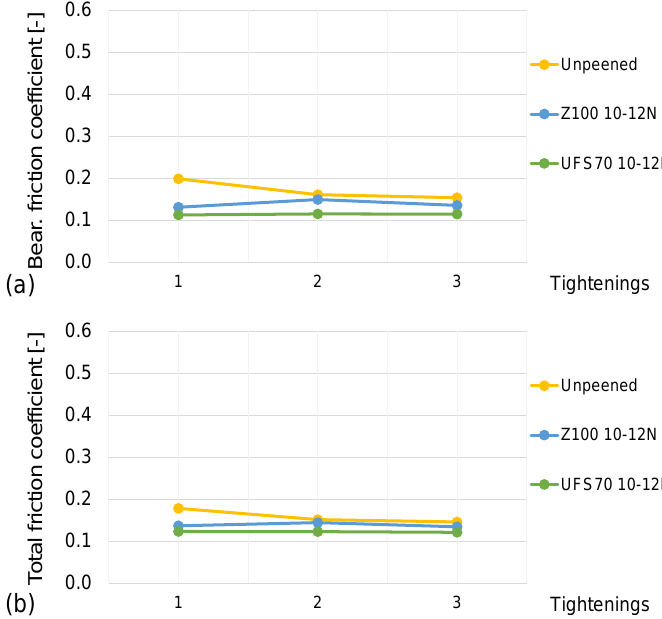
Figure 6. ( a ) Bearing and ( b ) friction coefficients plotted versus the number of tightenings for different peening treatments, with regard to the trials in lubricated conditions (data averaged regardless of deep-rolling execution).